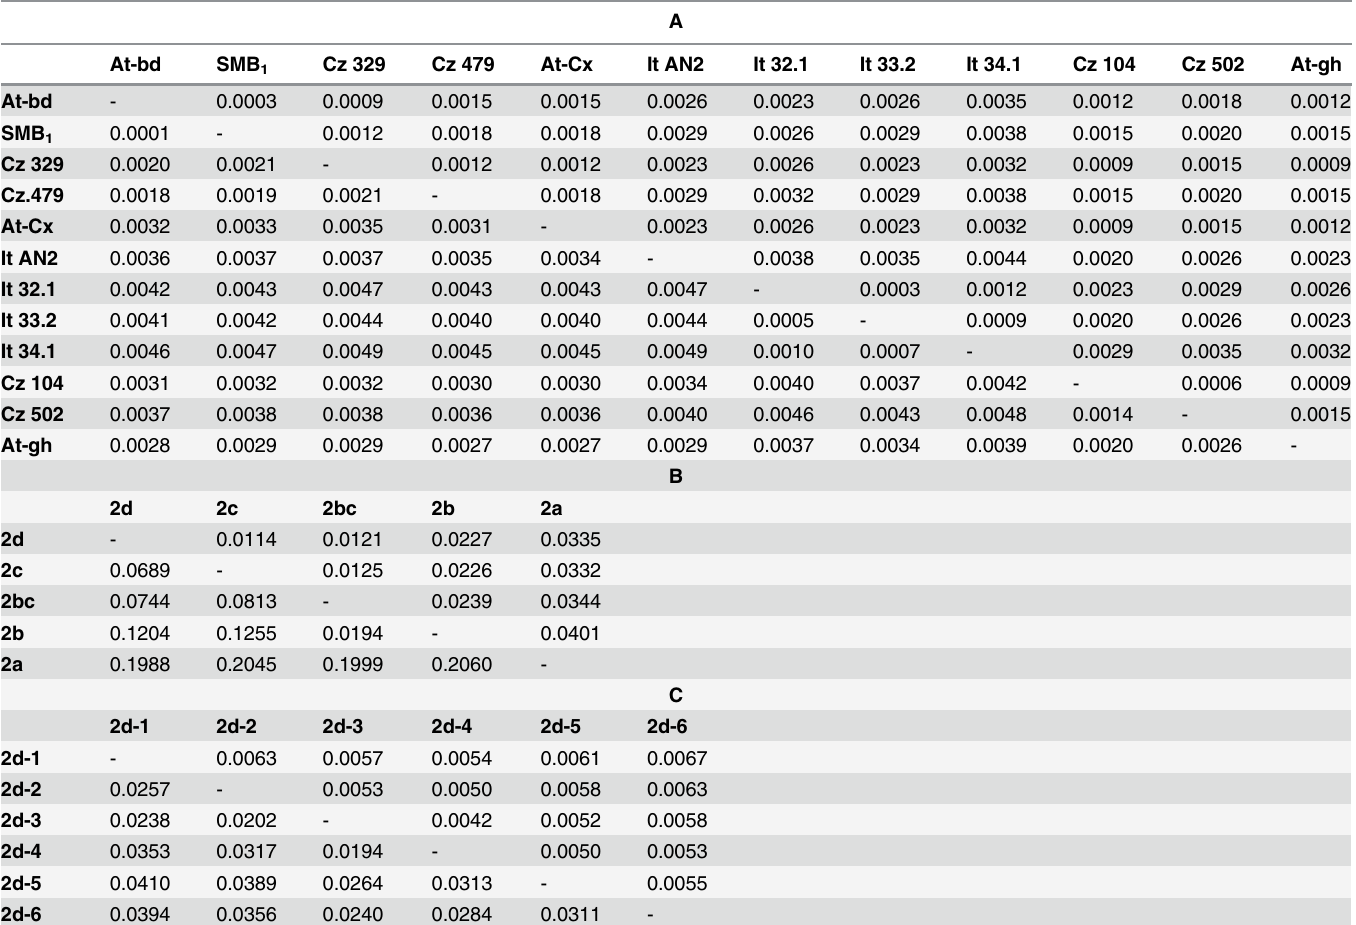
Table 2. Estimates of evolutionary pairwise distances A. over the Austrian strains (including the SMB 1 plasma isolate) and their nine closest rela- tives, B. five major groups (clades), and C. six minor groups (clusters) among clade 2d, all defined according to the clustering in the phylogenetic tree (Fig